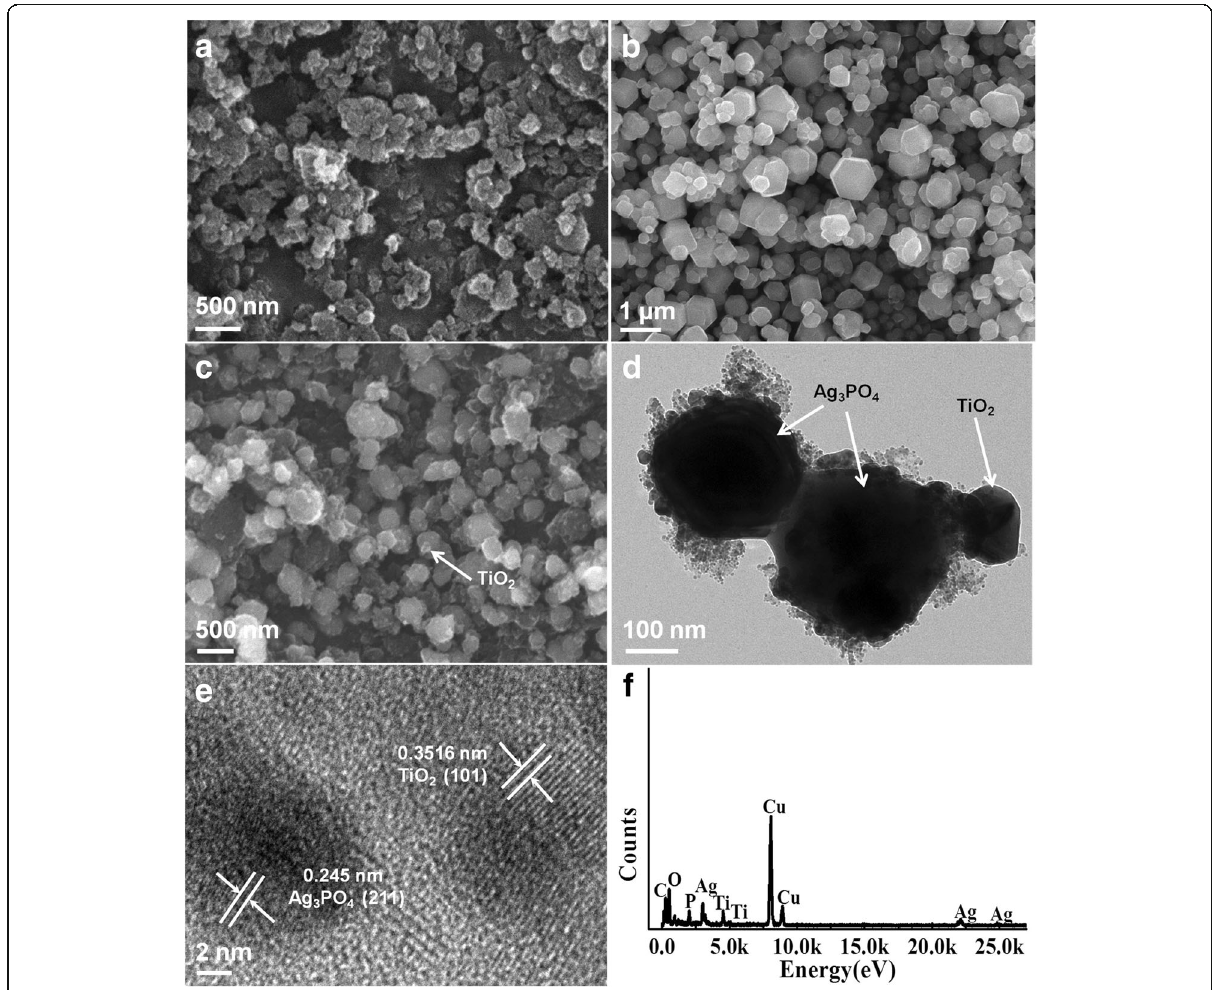
Fig. 2 SEM images of prepared photocatalysts: a TiO 2 400, b Ag 3 PO 4 , c TiO 2 400/Ag 3 PO 4 , d TEM image of TiO 2 400/Ag 3 PO 4 , e HRTEM image of TiO 2 400/Ag 3 PO 4 , and f corresponding EDX pattern of TiO 2 400/Ag 3 PO